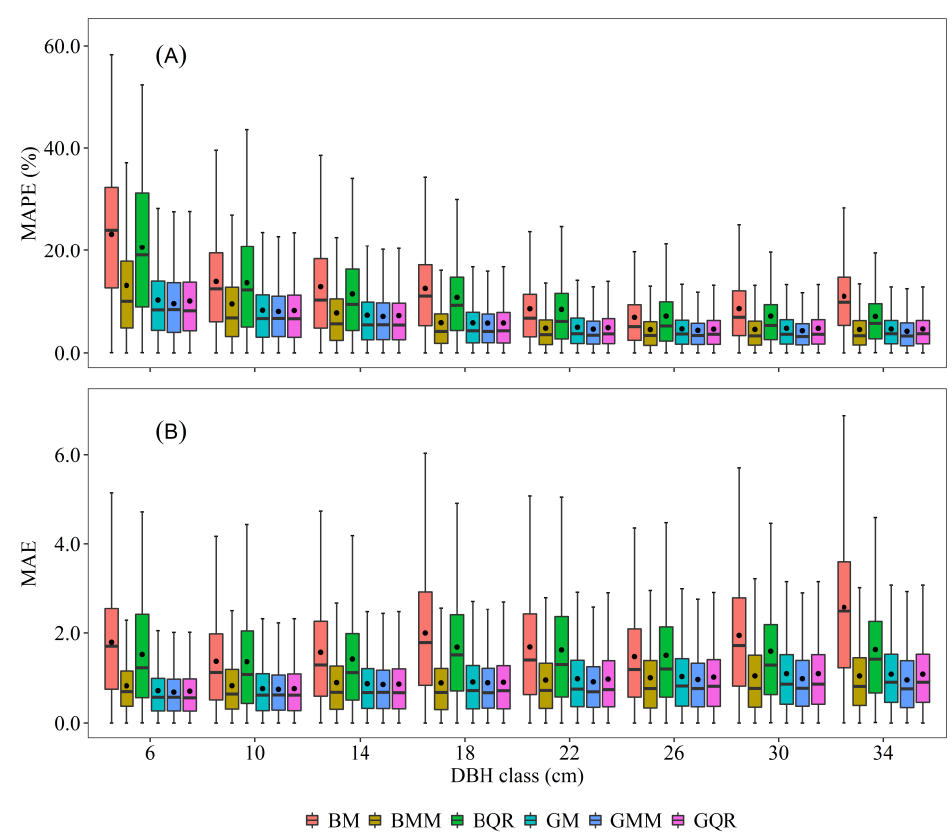
Figure 5. MAPE ( A ) and MAE ( B ) of the fit results for the BM, BQR, BMM, GM, GMM and GQR methods across several D classes. Solid symbols in each box represent the mean value.